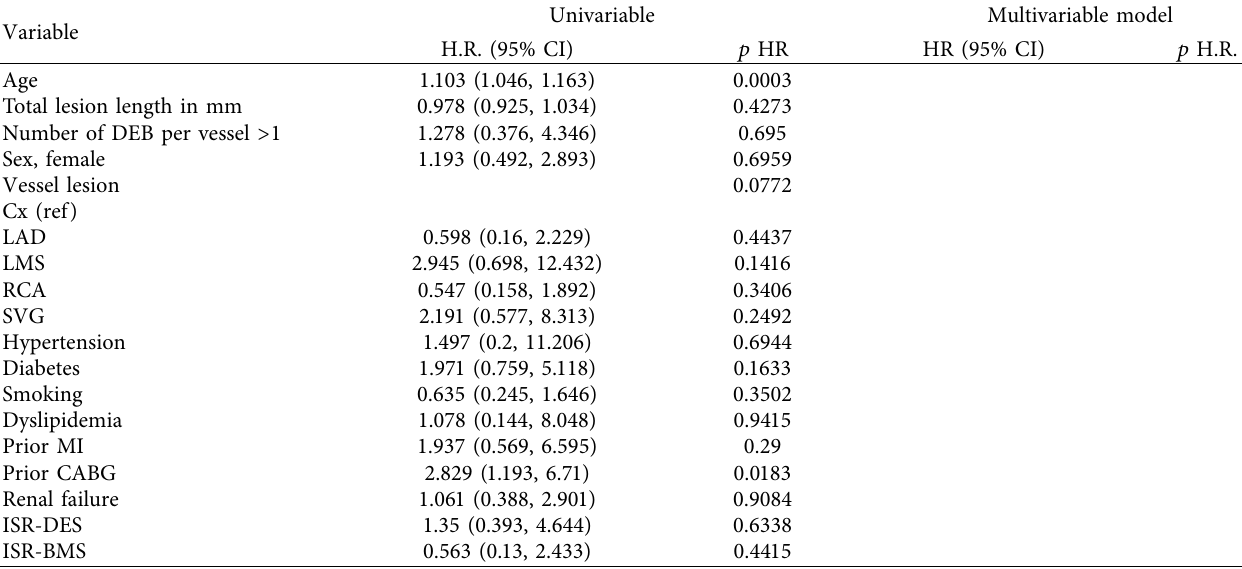
Table 7: Univariable and multivariable Cox proportional hazard (H.R.) for